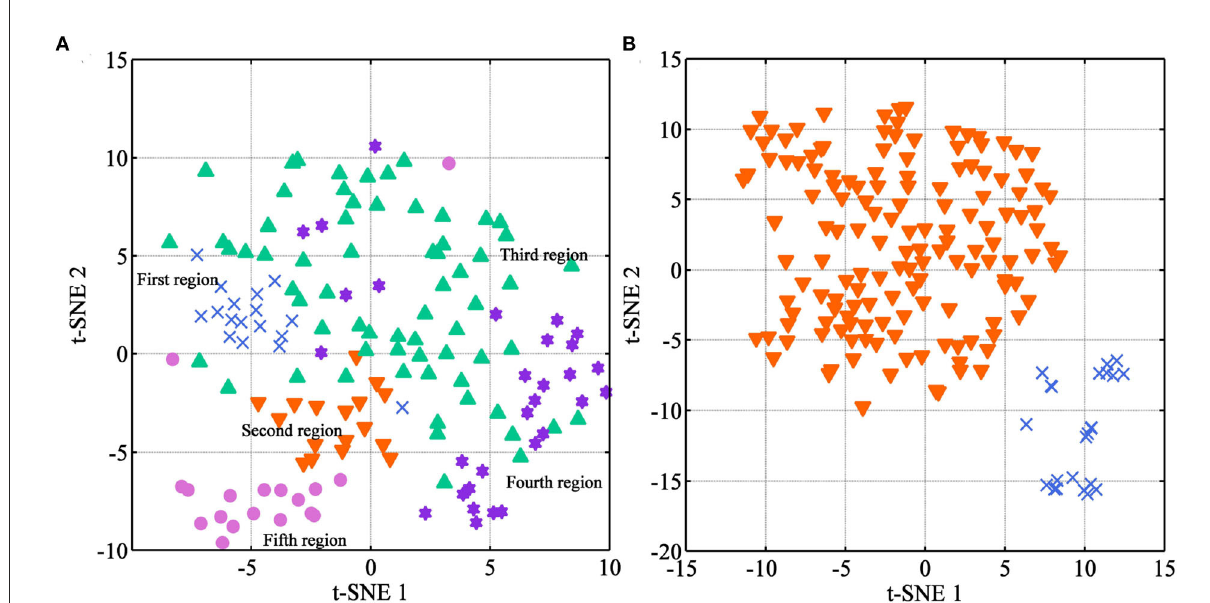
FIGURE6 The visualization distribution of multi-source samples using t-SNE (Description: (A) represents the visualization result for Danshen medicines from different regions; (B) represents the visualization result between Danshen and Non-Danshen medicines; T-SNE 1 and t-SNE 2 represent the scores on the X and Y axes of the spectral data after dimensionality reduction, respectively.).